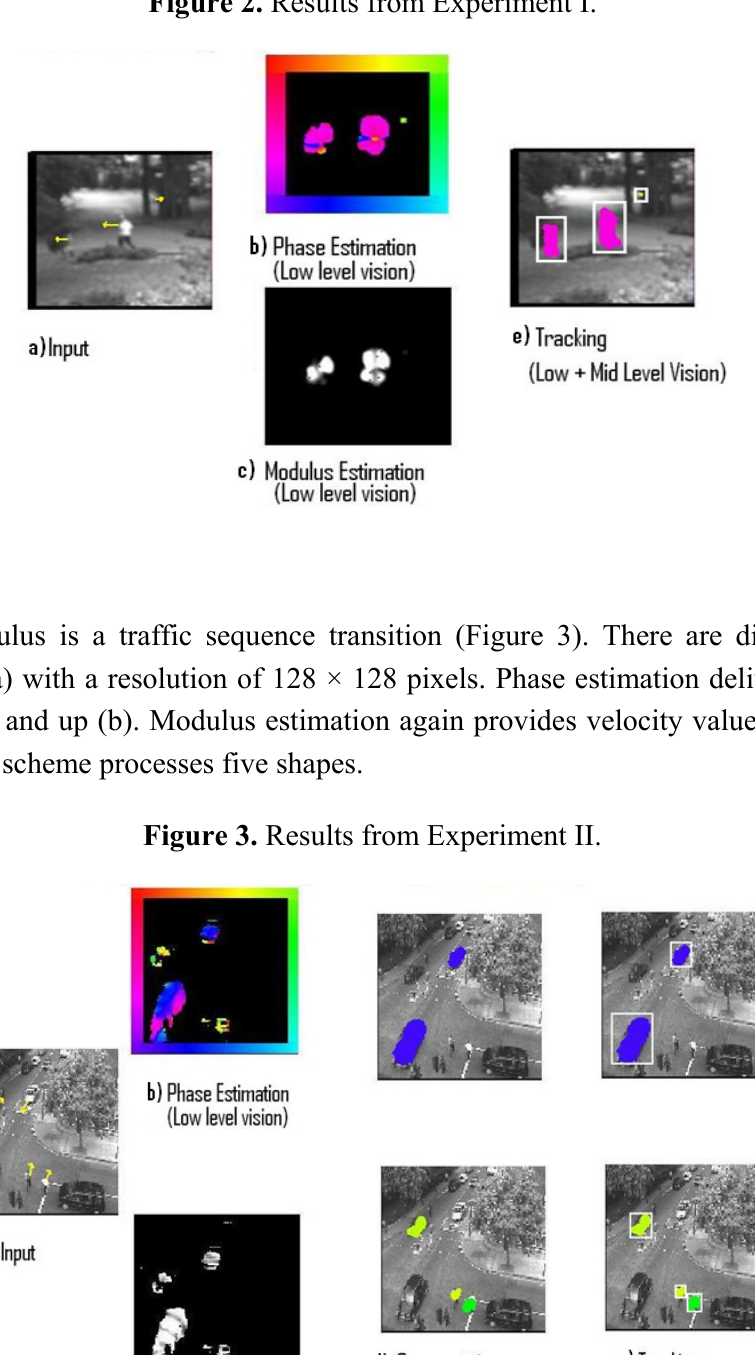
Figure 2. Results from Experiment I.